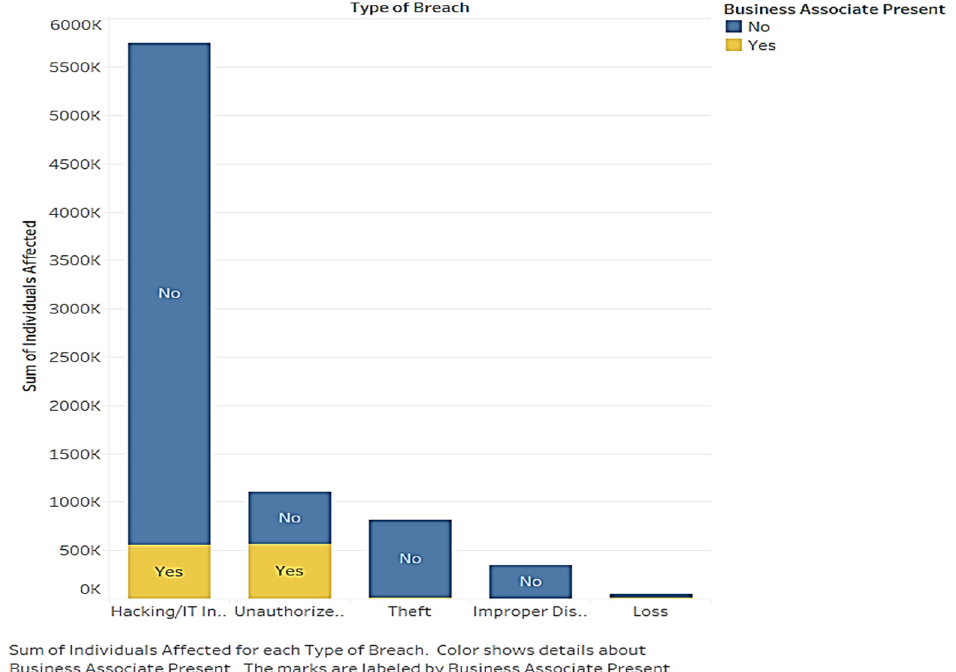
Figure 9. Breach type analysis by number of affected individuals and presence of business associates.